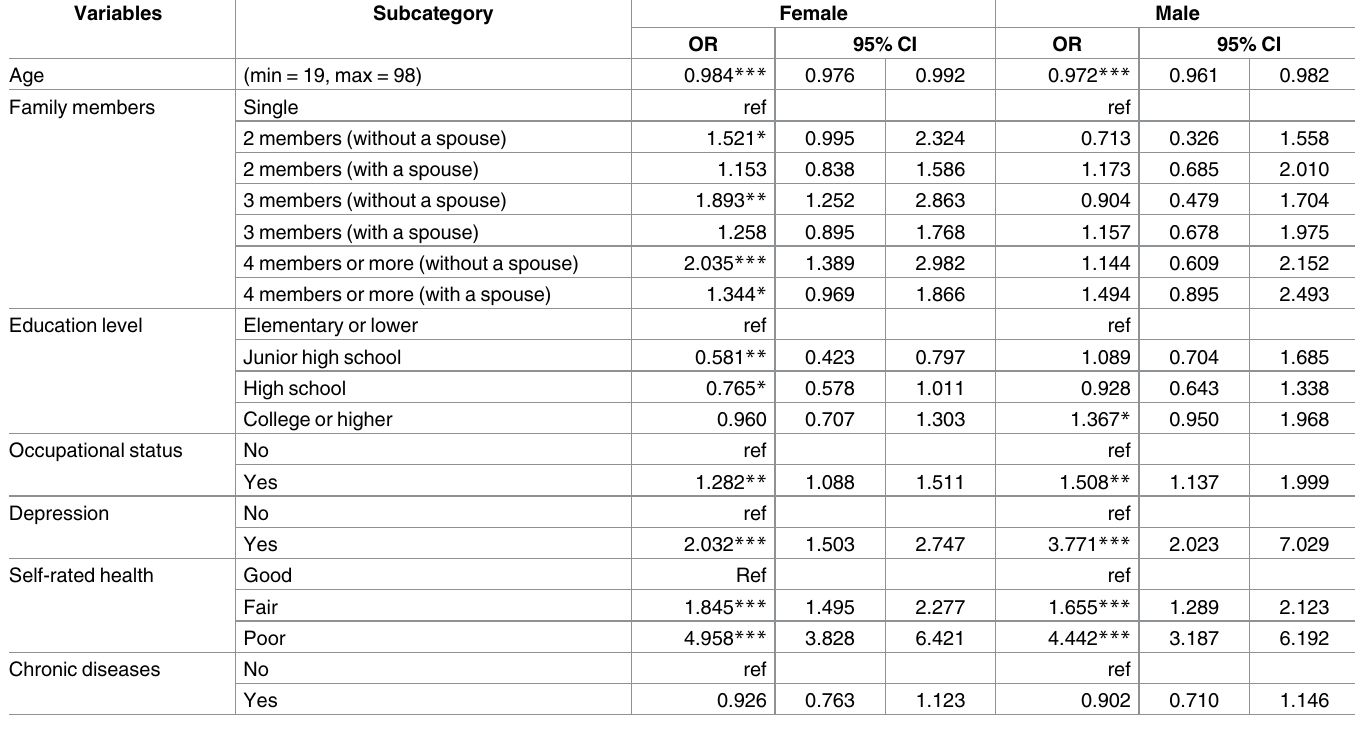
Table 2. Multivariable logistic regression analysis on perceived stressby